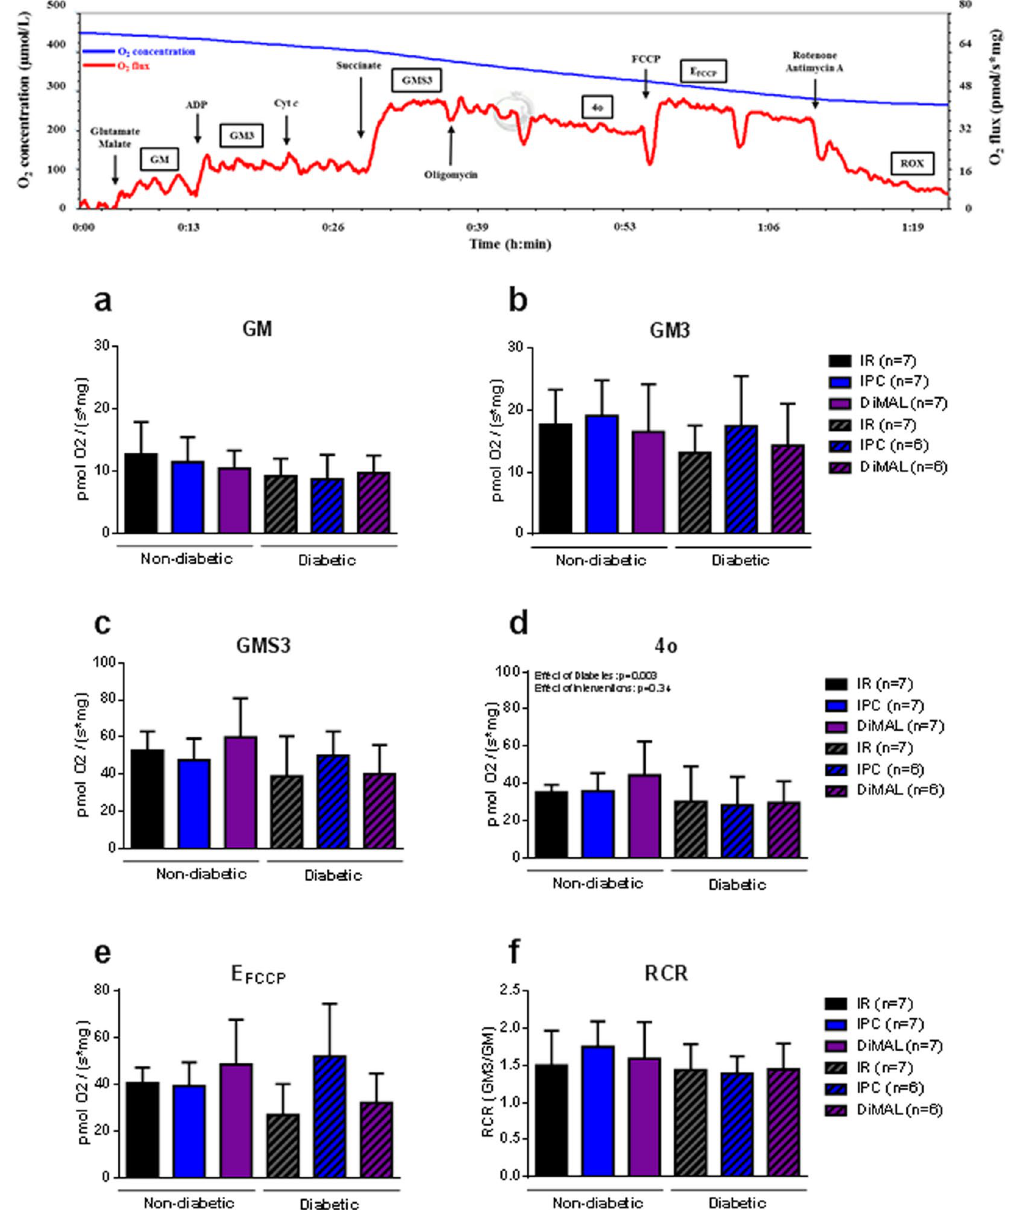
Figure 6. Human study - Mitochondrial respiratory capacity. Representative graph of mitochondrial respiratory capacity from an IR heart trabecula. Below mitochondrial respiratory capacity. GM, state 2 respiration with glutamate + malate ( a ); GM3, state 3 respiration with glutamate and malate ( b ); GMS3, state 3 respiration with glutamate, malate and succinate ( c ); 4o, state 4 respiration with oligomycin ( d ); FCCP, non- coupled state by FCCP ( e ); RCR with complex I-linked substrates ( f ). Data are mean ± SD. * P < 0.05 between indicated groups. P-values at the top indicate overall effect of diabetes and interventions by two-way ANOVA,